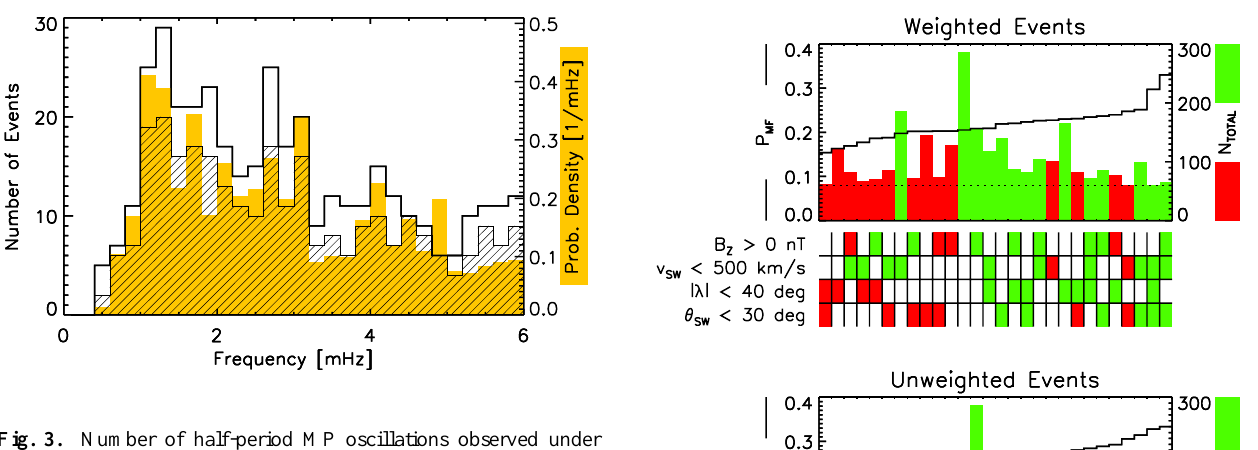
Fig. 3. Number of half-period MP oscillations observed under different conditions against frequency. The thick solid line his- togram depicts the original distribution as presented in Plaschke et al. (2009b). The hatched area shows the same distribution re- duced by those events for which no SW data from the OMNI dataset were available. Weighting of the events to approximate SW param- eter distributions shown in Fig. 2 yields the distribution depicted by the yellow bars. For this case the probability density function (normalized for integration in the interval between 0 and 6mHz) is indicated by the right axis.